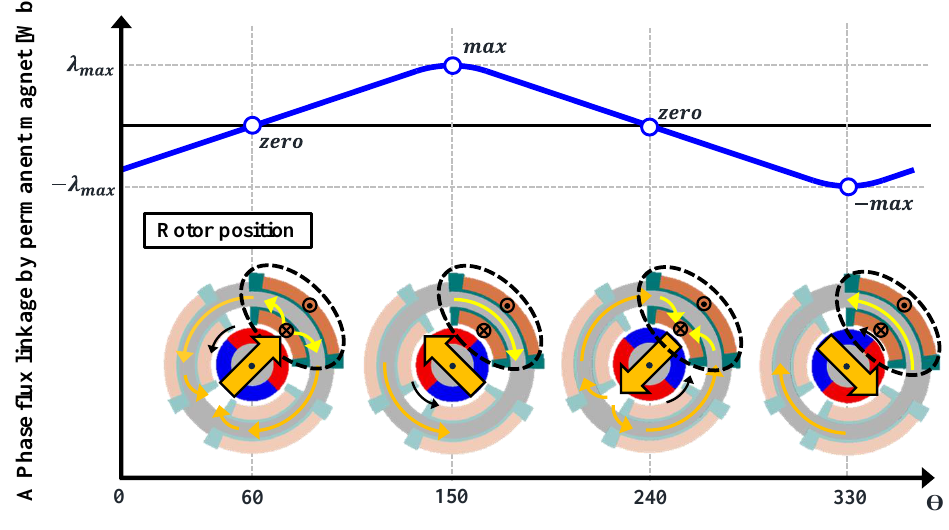
Figure 5. Flux-linkage waveform of A-phase coil by permanent magnet.